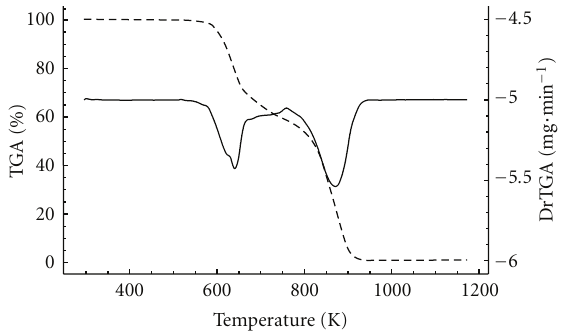
Figure 5: TG and DTG curves of resveratrol. ranging from 564 to 591 K ( Δ m = 97 . 6%) for PHBV and from 639 to 734 K ( Δ m = 97 . 7%) for